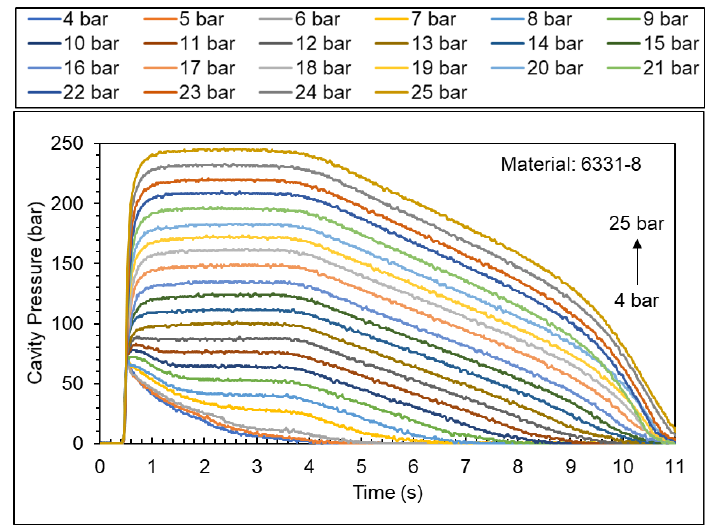
Figure A1. Cavity pressure profiles of 6331 − 8 at different packing pressures.